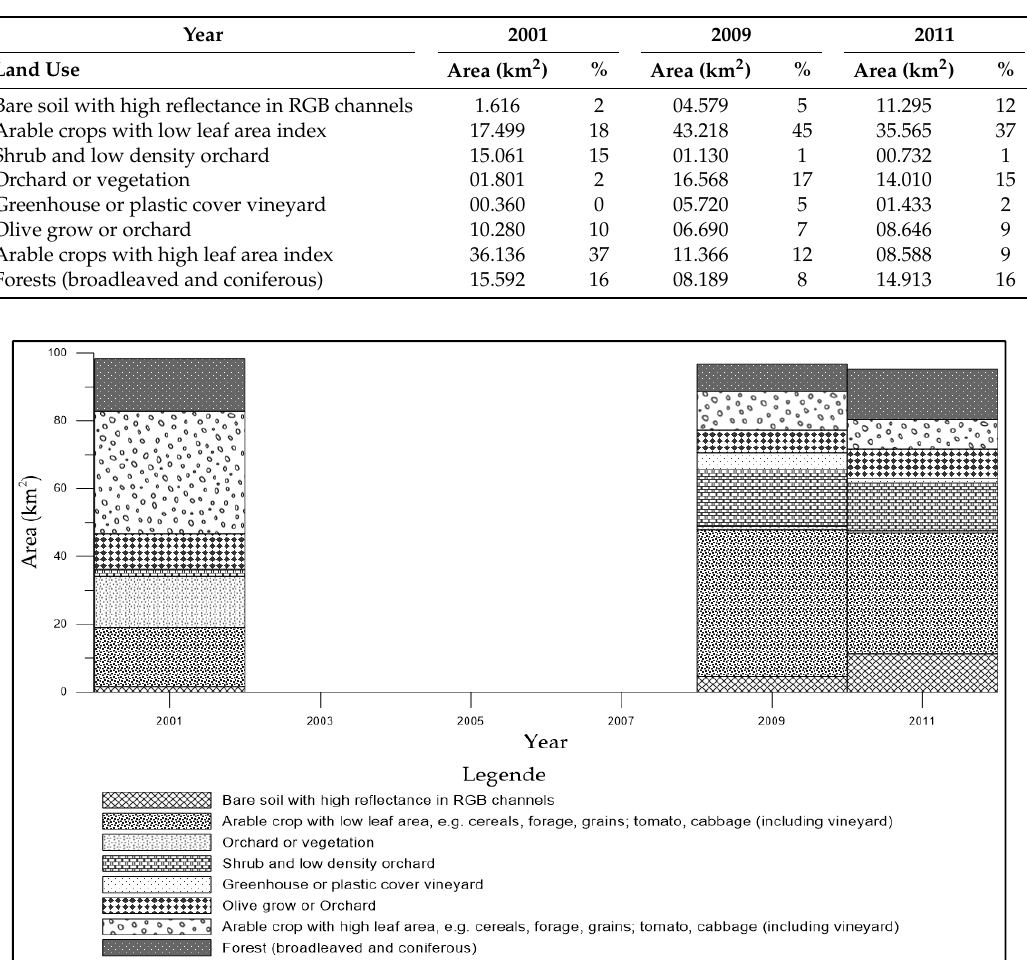
Table 4. Agricultural and forests area sub-classes.